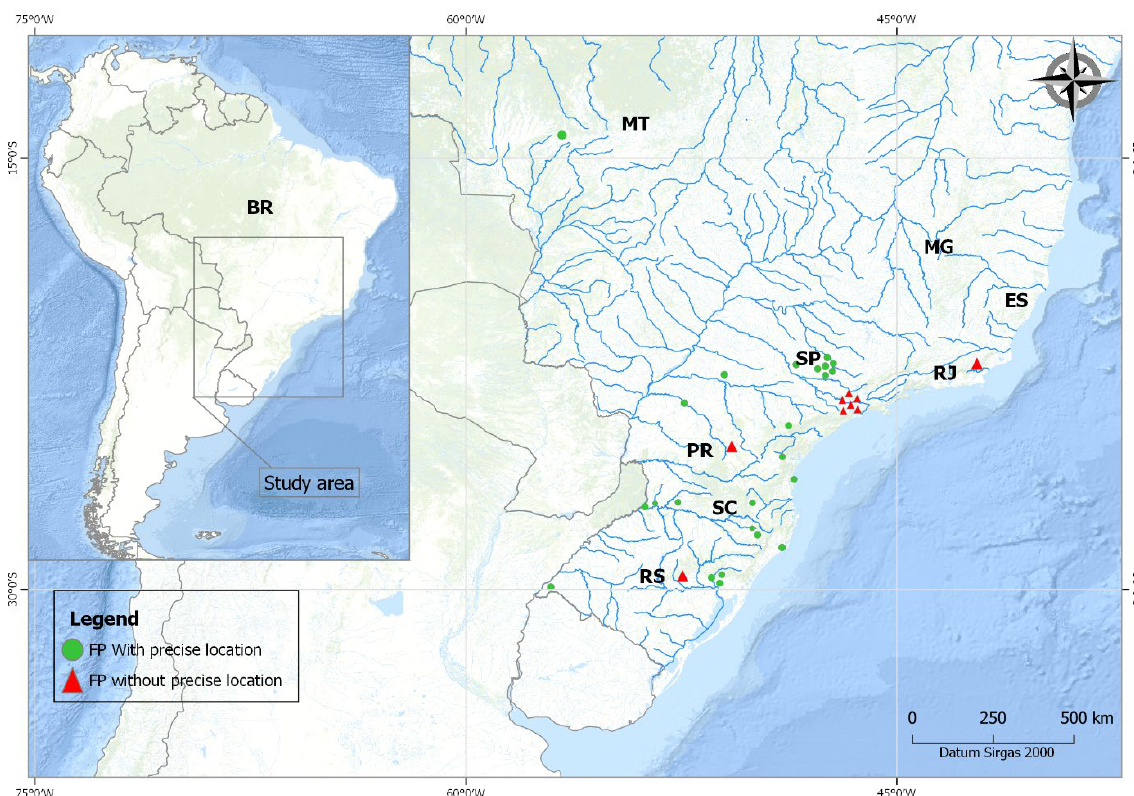
Figure 1. Study area with localization of the findings of FPs included in this study. Green circles: FP with precise location. Red triangles: FP without precise location. BR: Brazil. RS: Rio Grande do Sul State. SC: Santa Catarina State. PR: Paraná State. SP: São Paulo State. RJ: Rio de Janeiro State. ES: Espírito Santo State. MG: Minas Gerais State. MT: Mato Grosso